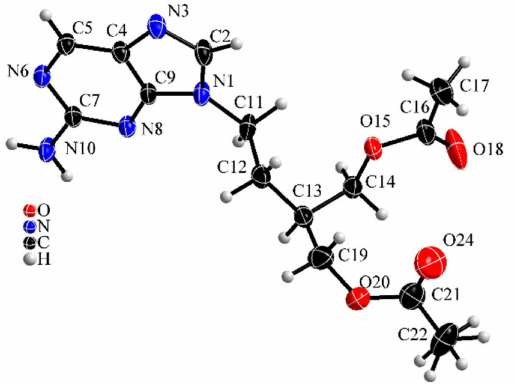
Figure 6. Molecular structure of anhydrous famciclovir (form I). Thermal ellipsoids are drawn on 50%